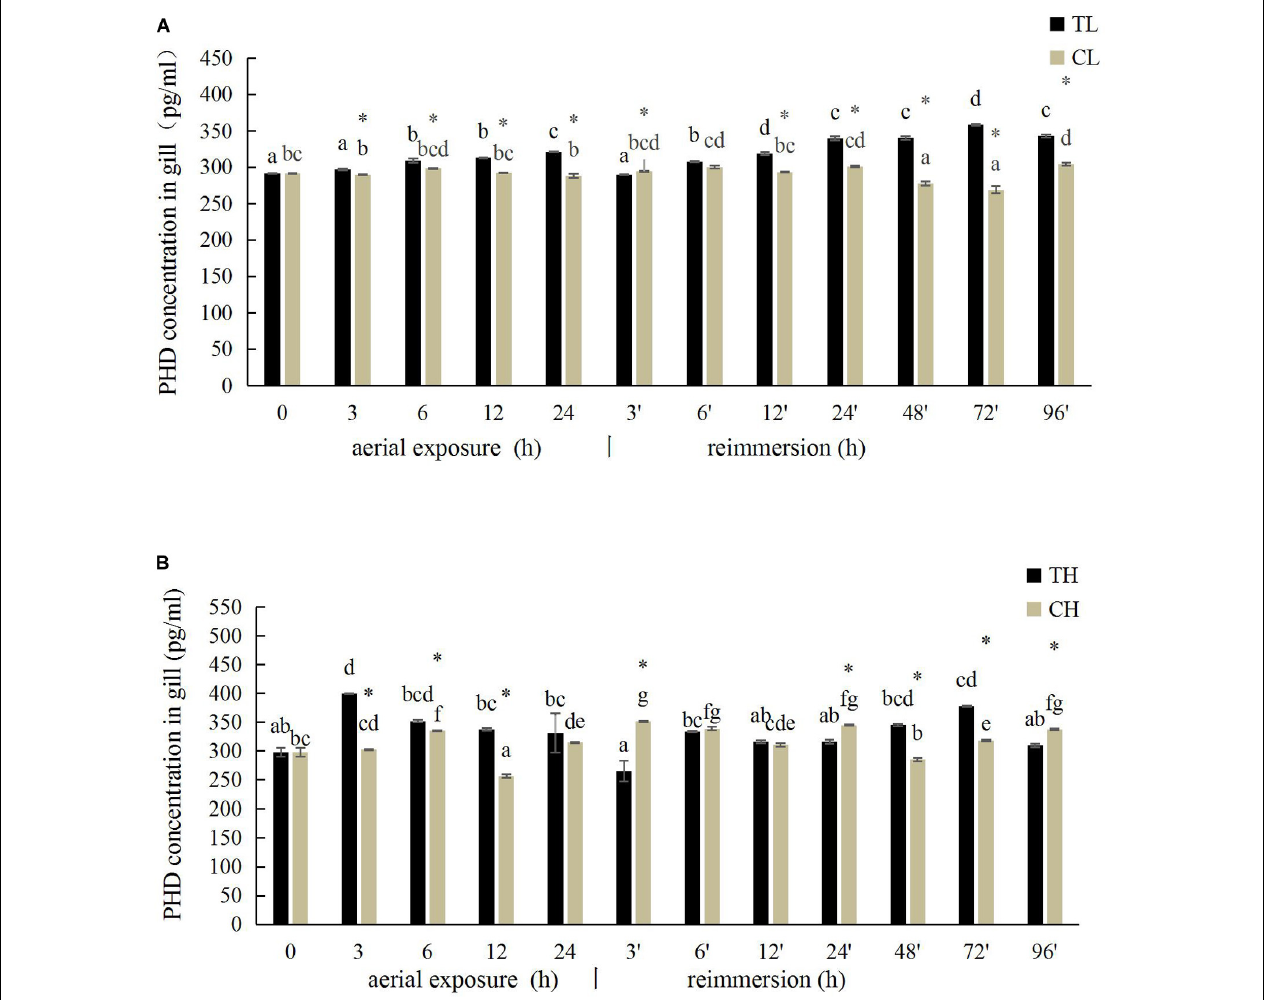
FIGURE 5 | Effects of aerial exposure on PHD in gill of R. philippinarum under low temperature (A) and high temperature (B) .